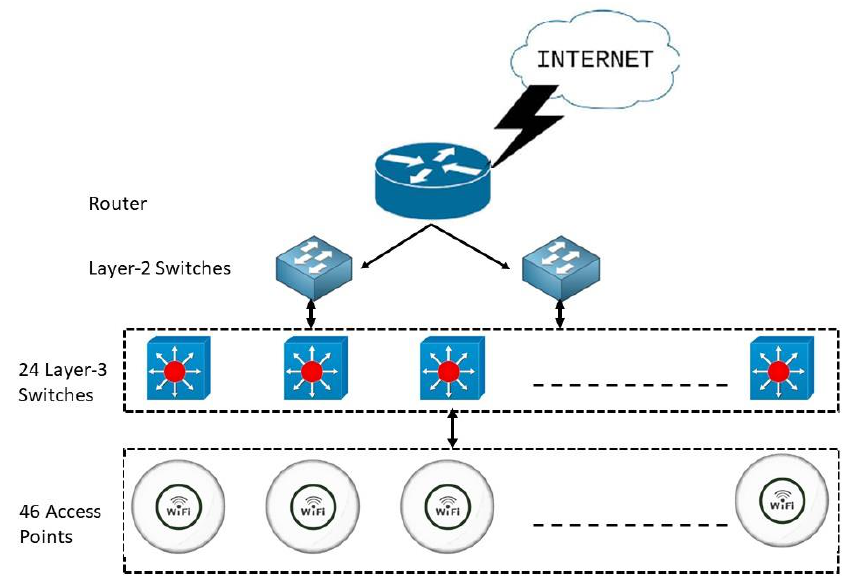
Figure 2. SDN-based architecture.